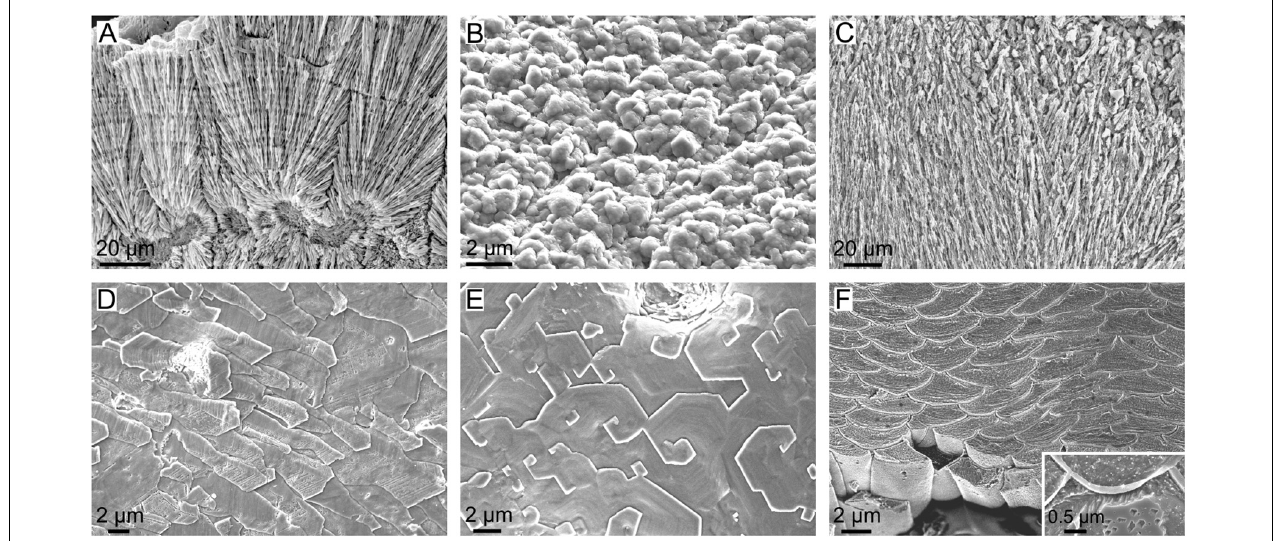
FIGURE 12 | Microstructures of calcifying invertebrates other than mollucs. (A) Fibrous aragonite of the scleractinian coral Goniastrea stelligera (etched fracture). (B) Calcitic granular microstructure of the balanomorph crustacean Perforatus perforatus (growth surface), Salobreña, Granada, Spain. (C) Aragonitic spherulitic prismatic structure of the serpulid polychaete Spiraserpula caribensis (polished and etched section), Netherlands Antilles, Curaçao. (D) Foliated calcite of the stenolaemata bryozoan Fasciculipora ramosa (growth surface), Australia. (E) Semi nacre of the cranioidea brachiopod Novocrania anomala (growth surface), Scotland. (F) Calcitic fibers of the secondary layer of the terebratulid brachiopod Laqueus rubellus (polished and etched section). Inset, close-up view of a similar fiber of the brachiopod Terebratalia transversa , showing the organic membranes between